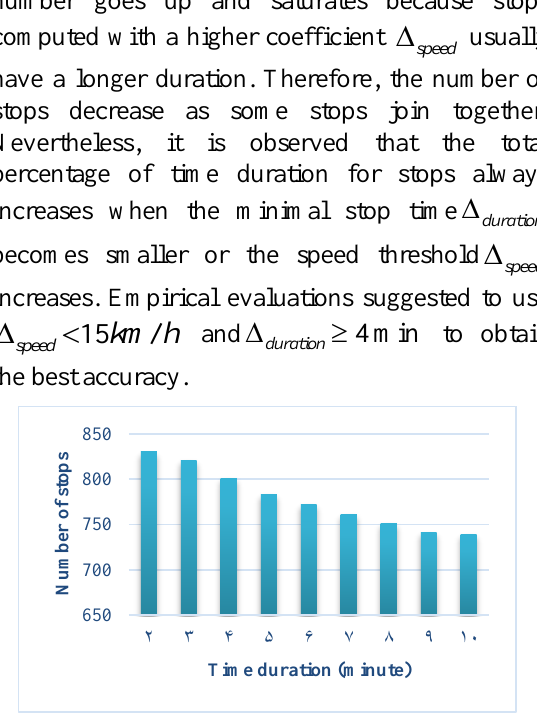
Figure 8. Number of stops based on different time durations (similar graph for speed).